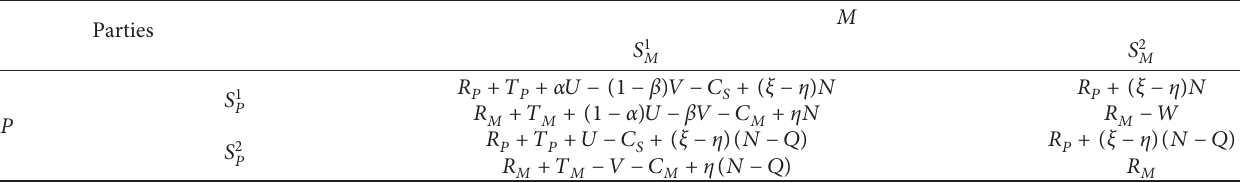
Table 1: The payoff